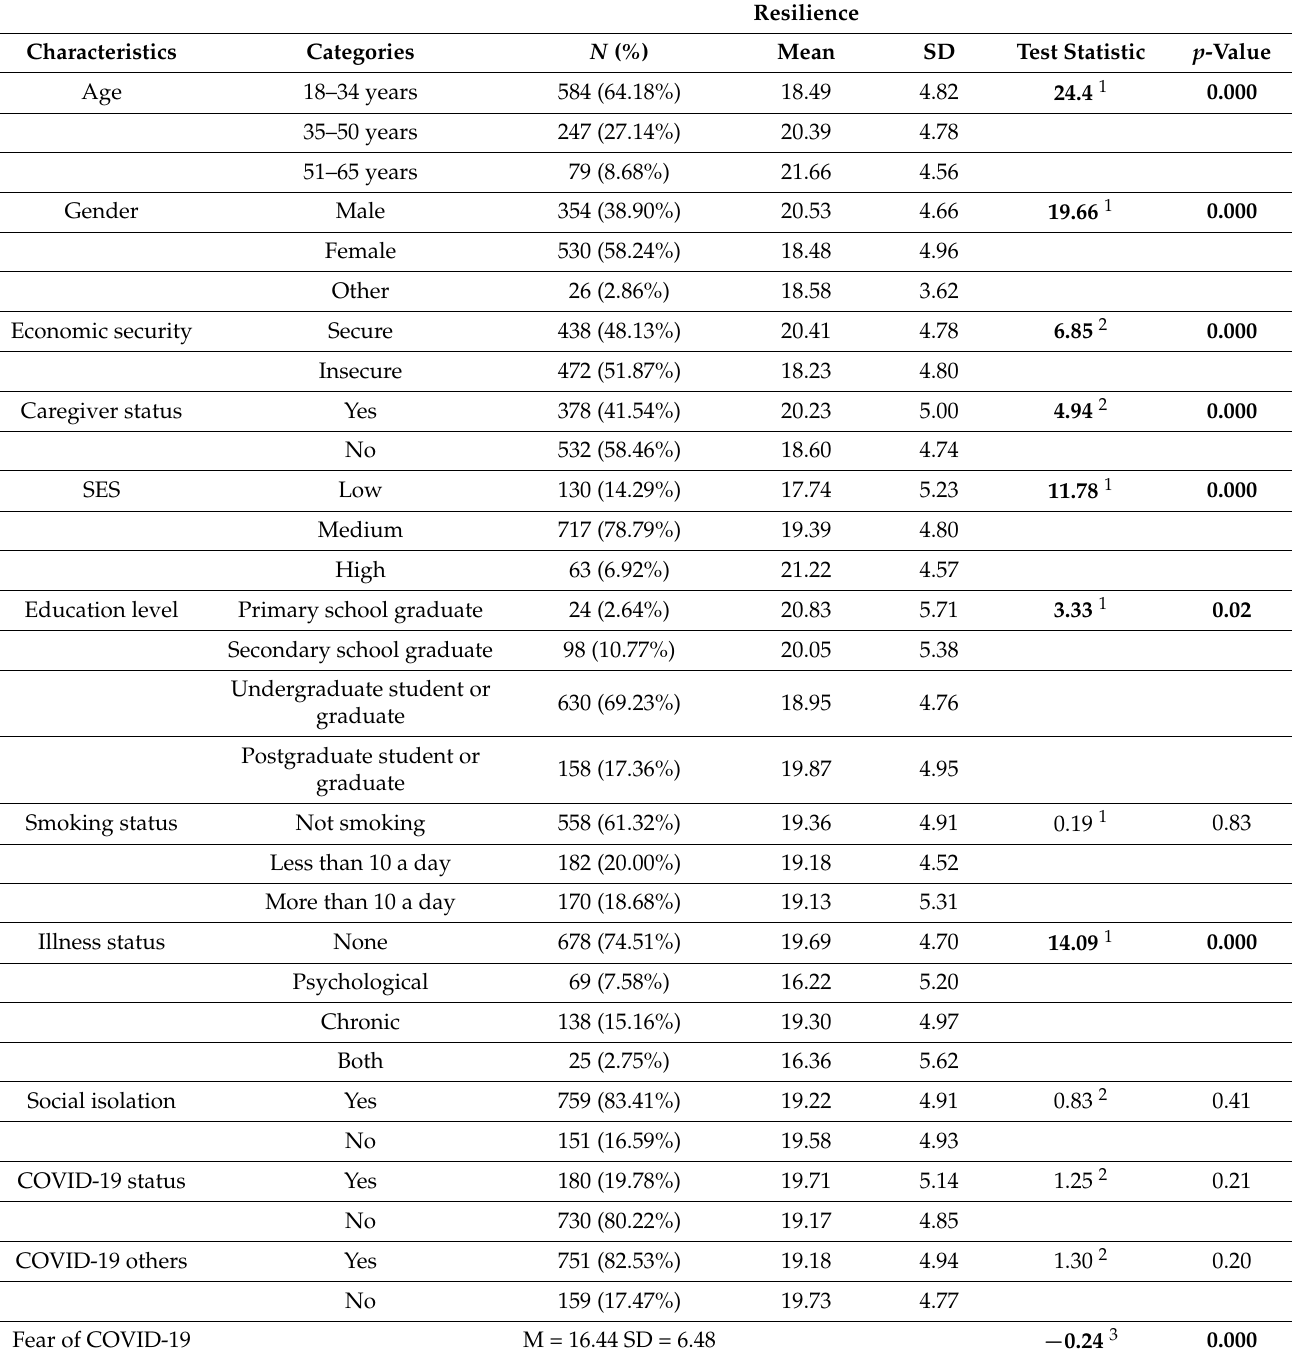
Table 1. Sample characteristics and the relationship of resilience with study variables ( N =